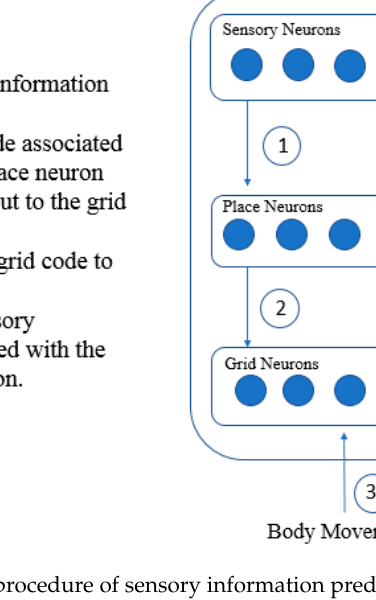
Figure 13. The procedure of sensory information prediction.